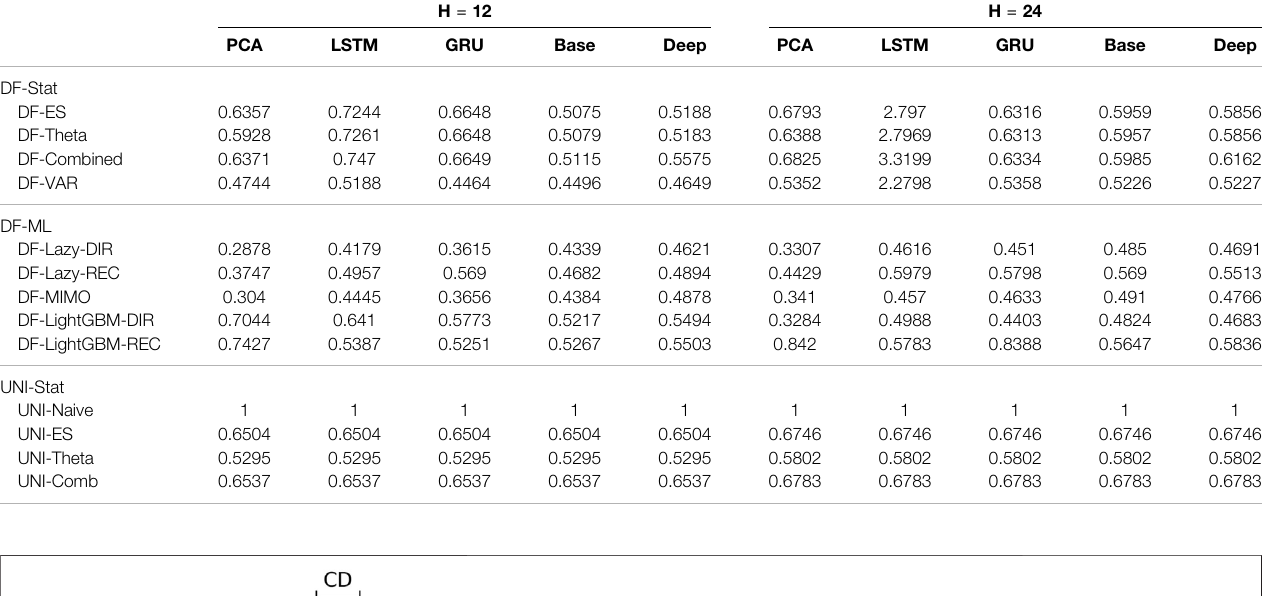
TABLE 5 | Electricity Naive Normalized MSE for H ∈ {12, 24}. The content of the cell c ij represents the model using the j th dimensionality reduction technique with the i th forecasting method. The NNMSE for the Naive method is equal to 1. An NNMSE < 1 indicates that the proposed method outperforms the Naive method.